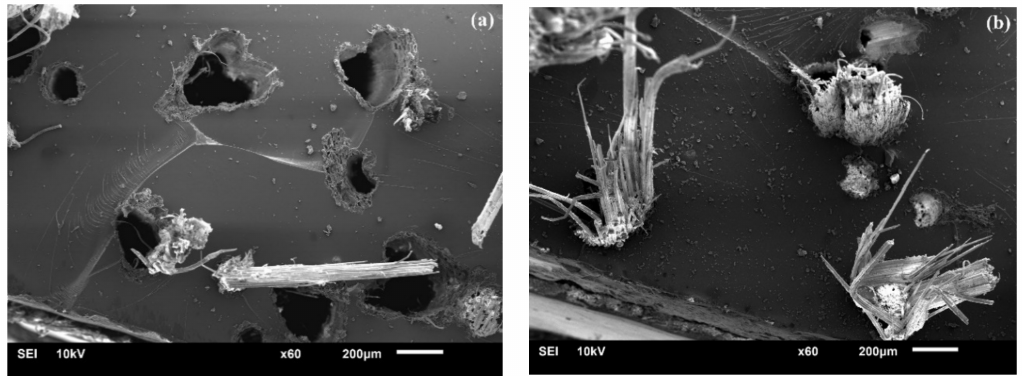
Figure 5. SEM images of tensile fracture surface of: ( a ) UTFC; and ( b ) ATFC.